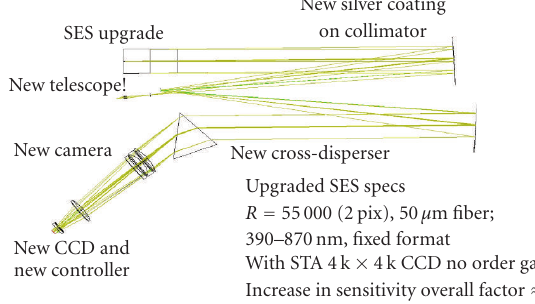
Figure 7: Layout of the 2010+ version of the SES. The fiber connection remains to be based on a 50 μ m Polymicro fiber and the EFO-Quartz principle. The resolution and wavelength coverage remain, the latter without any gaps due to the larger CCD and new cross-disperser. The overall e ffi ciency shall be increased by a factor of three to ≈ 10% (all inclusive) compared to the current SES